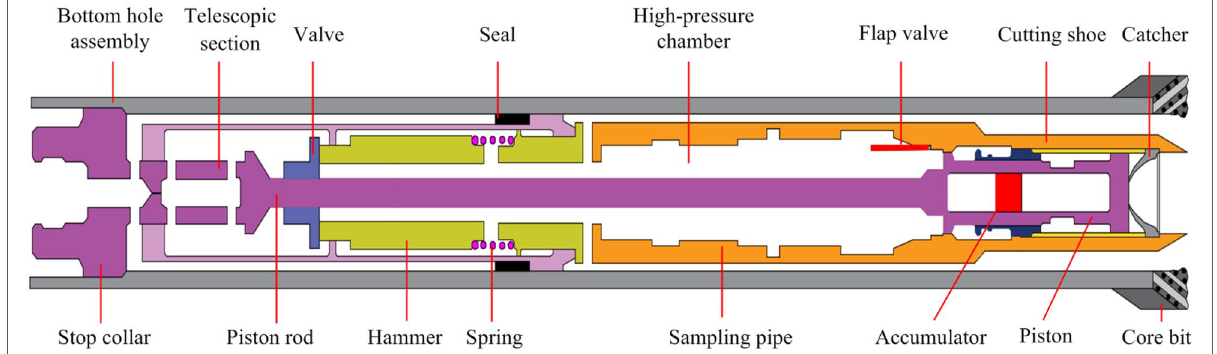
Figure 3 Schematic of the Fugro pressure corer (FPC)